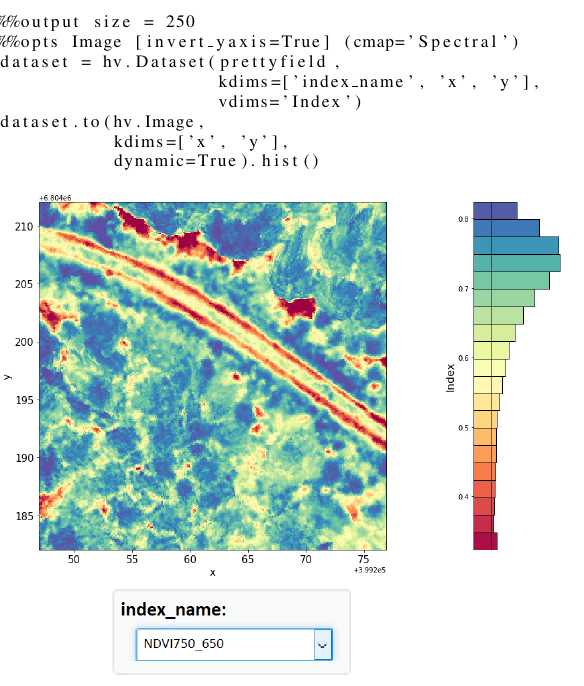
Figure 24. All indices in a dropdown menu. Dropdown menu comes from the use of Holoviews